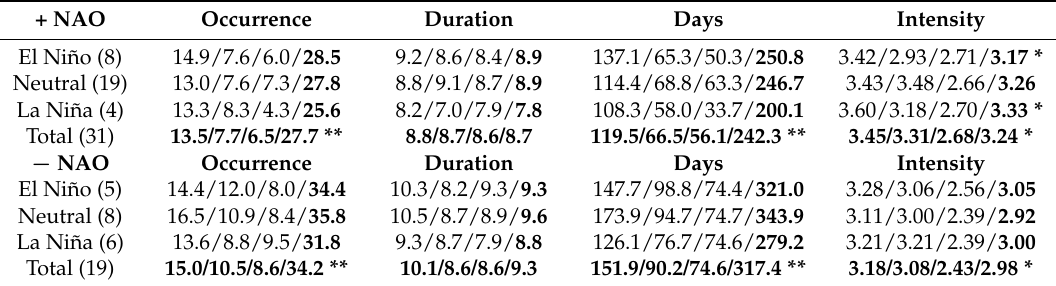
Table A1. NH blocking events per year by region (ATL/PAC/CON/ Total ) as a function of ENSO and NAO. The number of years in each category is shown in parentheses. Here statistical significance is indicated with * (**) at the 90% (95%) confidence